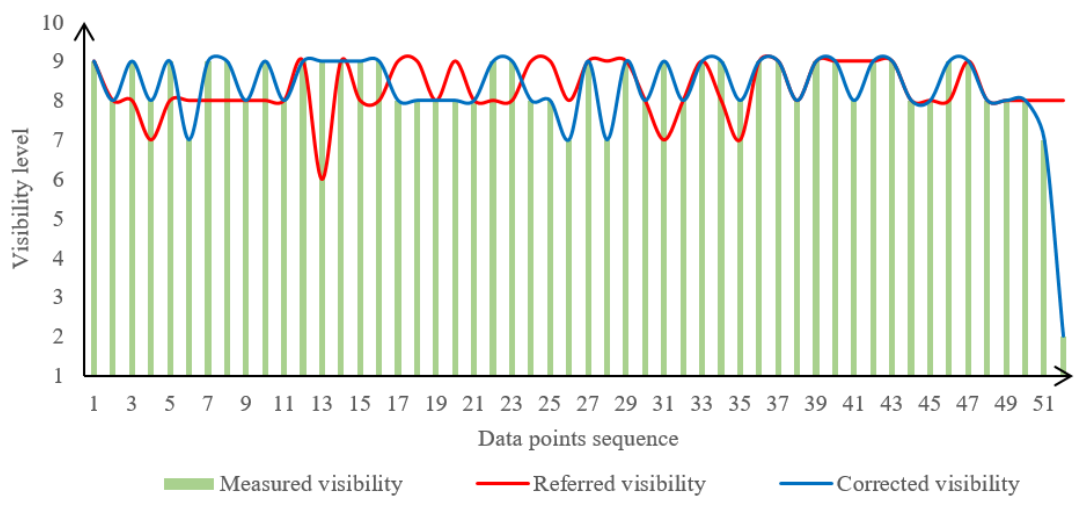
Figure 7. Comparison of referred Vis, corrected Vis, and measured Vis.